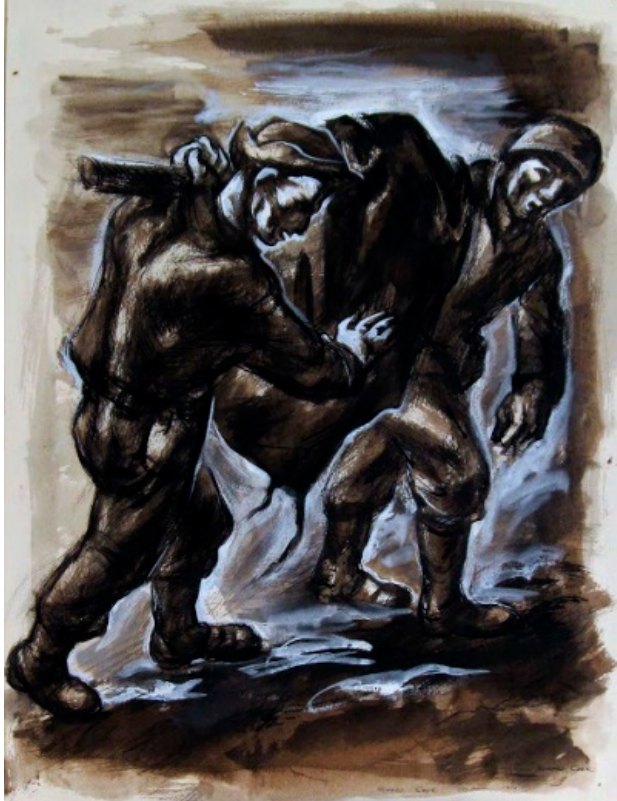
Figure 6. Howard Cook, Carrying Equipment , Guadalcanal , 1943, mixed media on paper. Permanent Collection of the Roswell Museum and Art Center, Gift of the Artist, 1973.031.0228. Used with permission.